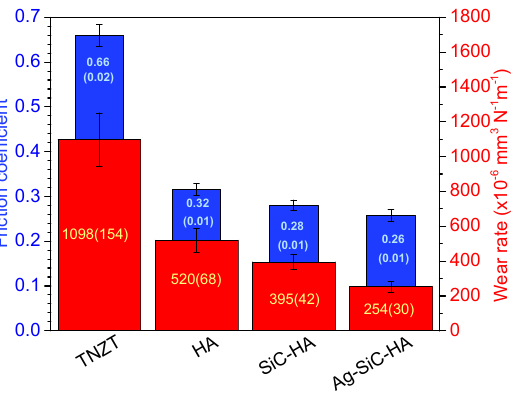
Figure 15. Friction coefficient and wear rate of bare and coated TNZT alloy obtained via tribology test carried out in SBF solution at 37 ± 1 °C.